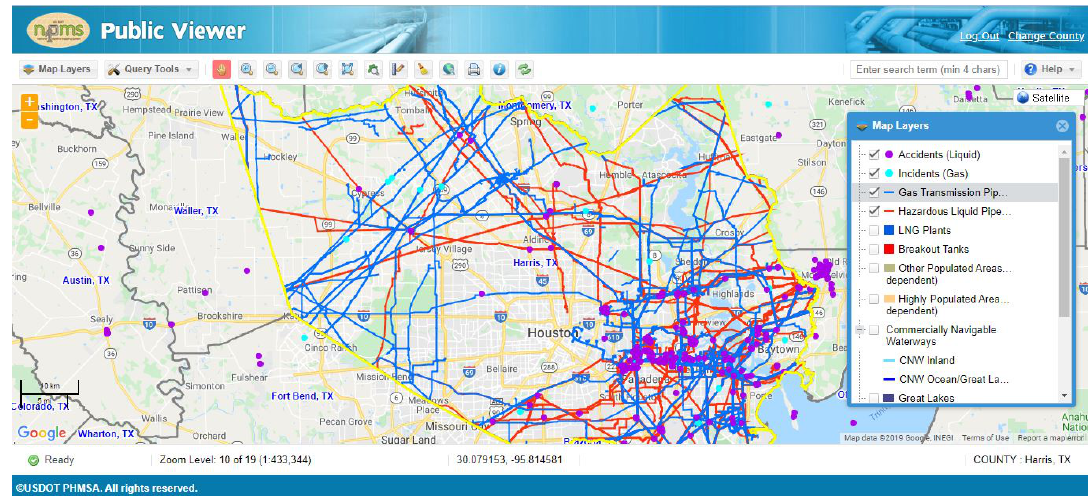
Figure 1. National Pipeline Mapping System (NPMS) Public Viewer for Harris county,